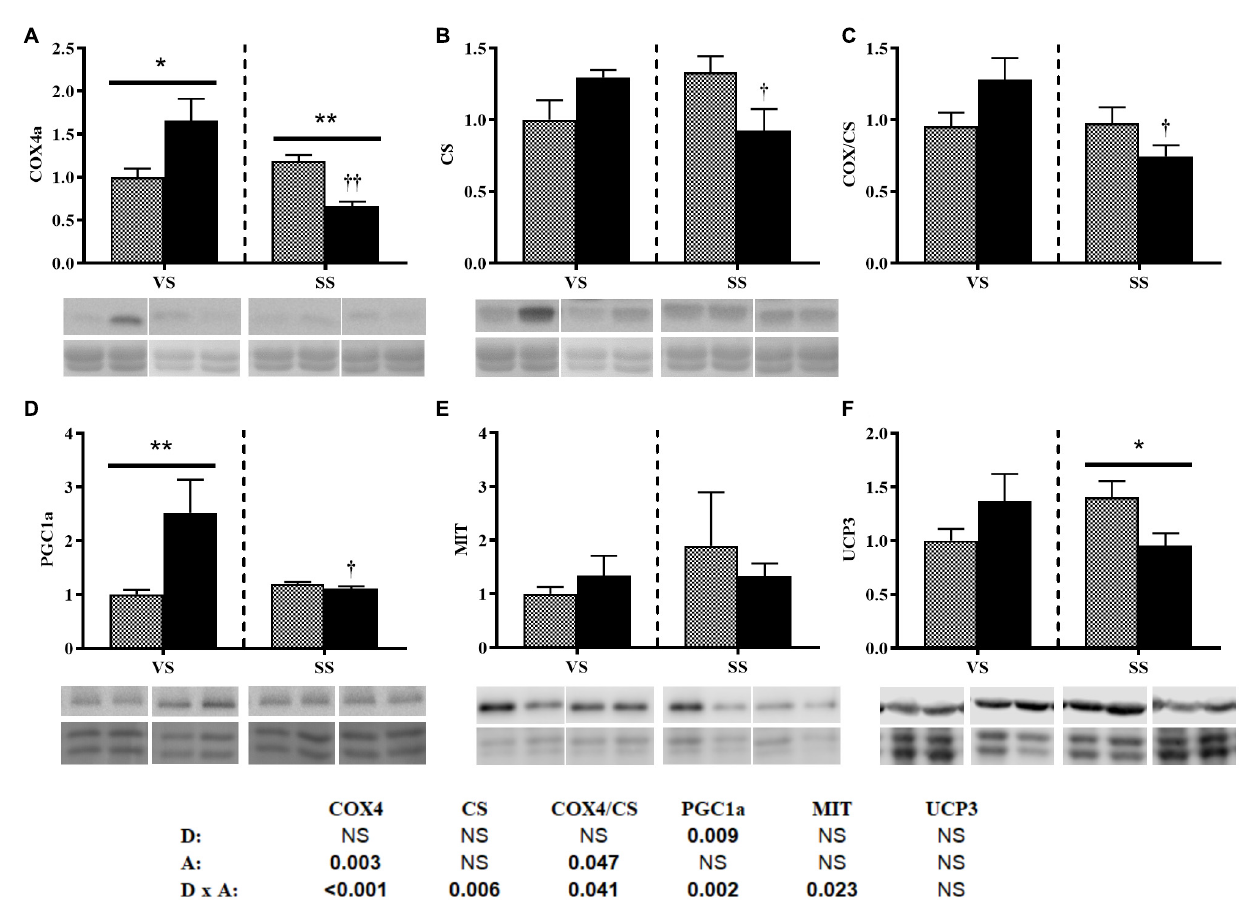
FIGURE 4 | Representative western blot and densitometric analysis of the protein levels of COX4 (A) , CS (B) , the COX/CS ratio (C) , PGC1a (D) , MIT1/2 (E) , and UCP3 (F) in the white skeletal muscle of gilthead seabream fed the HP or HE diet under conditions of (A) voluntary swimming (VS) or (B) sustained swimming (SS). Bands were normalized to their RevertTM total protein staining (the corresponding well is shown). To eliminate intermembrane variability, the relative intensity of each specific band was normalized by the geometric mean of the intensity of that of the VS HP diet group of the corresponding membrane. For COX4a and CS, the blots were performed from the same membranes which were split before the primary antibody incubation. Data are shown as the mean ± SEM ( n = 6). The factorial statistical analysis was assessed by two-way ANOVA and the p -values of the diet (D), swimming activity (A) and the interaction (D × A) are displayed at the bottom of the figure. Pairwise comparisons were assessed by unpaired Student’s t -test. ∗ p < 0.05 and ∗∗ p < 0.01 between diet groups (HP and HE); † p < 0.05 and †† p < 0.01 between swimming activity groups (VS and